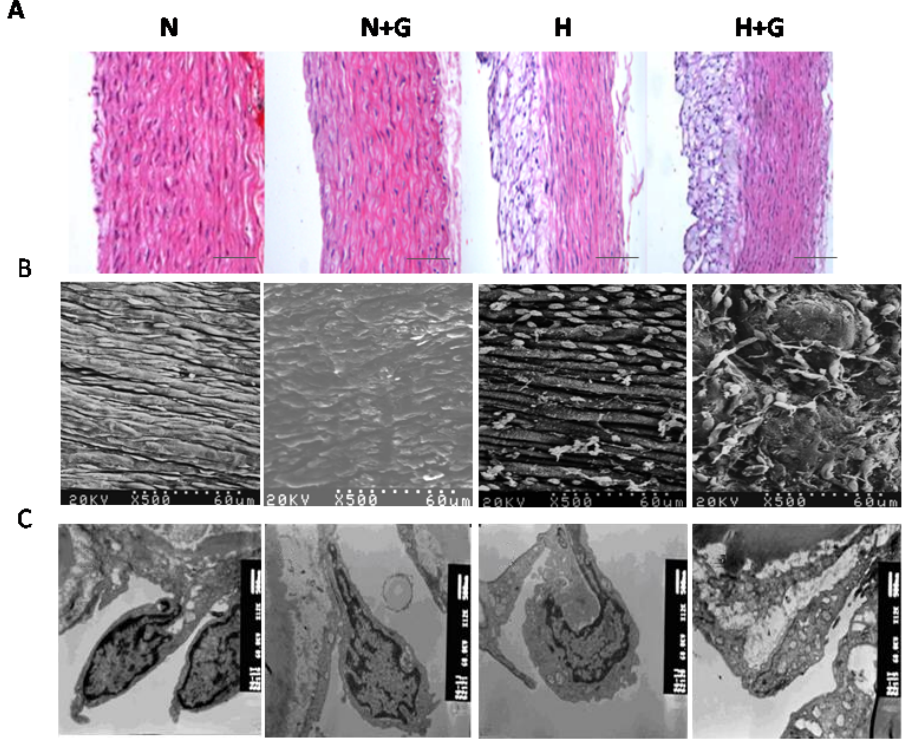
Figure 3. Impairment and apoptosis analysis of endothelial cells of thoracic aortae. ( A ) HE-stained thoracic aortae were analyzed by optical microscope. Ultrastructural changes of endothelial cells of thoracic aortae were observed by scanning electron microscope ( B ) and transmission electron microscope ( C ) analysis. N: normal diet group ( n = 3). N + G: normal diet group treated with G-CSF ( n = 3). H: high-fat diet group ( n = 3). H + G: high-fat diet group treated with G-CSF ( n = 3). ( A ): Scale bar: 200 μ